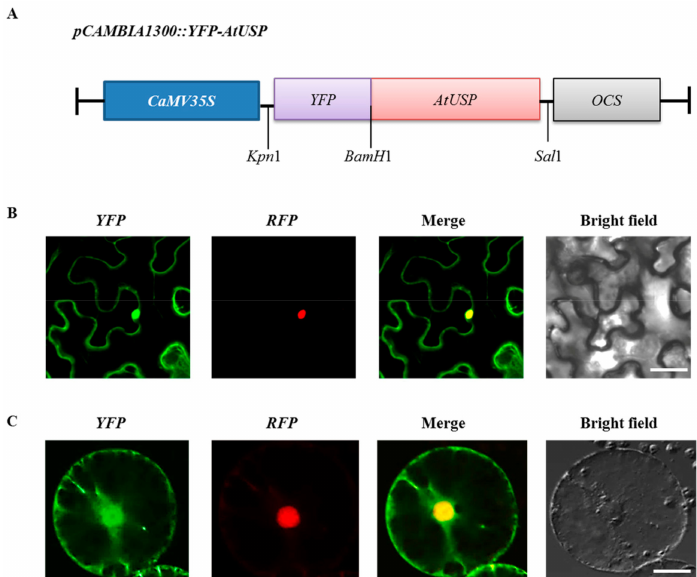
Figure 3. Subcellular localization of AtUSP in tobacco leaves and protoplasts. ( A ) Schematic representation of the YFP-AtUSP construct. CAMV35s and OCS indicate Cauliflower mosaic virus 35S promoter and octopine synthase terminator, respectively. ( B ) Confocal images of tobacco leaf abaxial epidermis and ( C ) isolated protoplast following co-transfection with the fusion protein constructs. From left to right: YFP and red fluorescent protein (RFP) (nuclear localization signal (NLS)-RFP) fluorescence, merged image of YFP and RFP (merge), and bright field image. NLS-RFP (chimeric protein with the simian virus 40 (SV40) large T antigen NLS fused N-terminal RFP) was used as nuclear marker protein. Scale bar = 20 µ